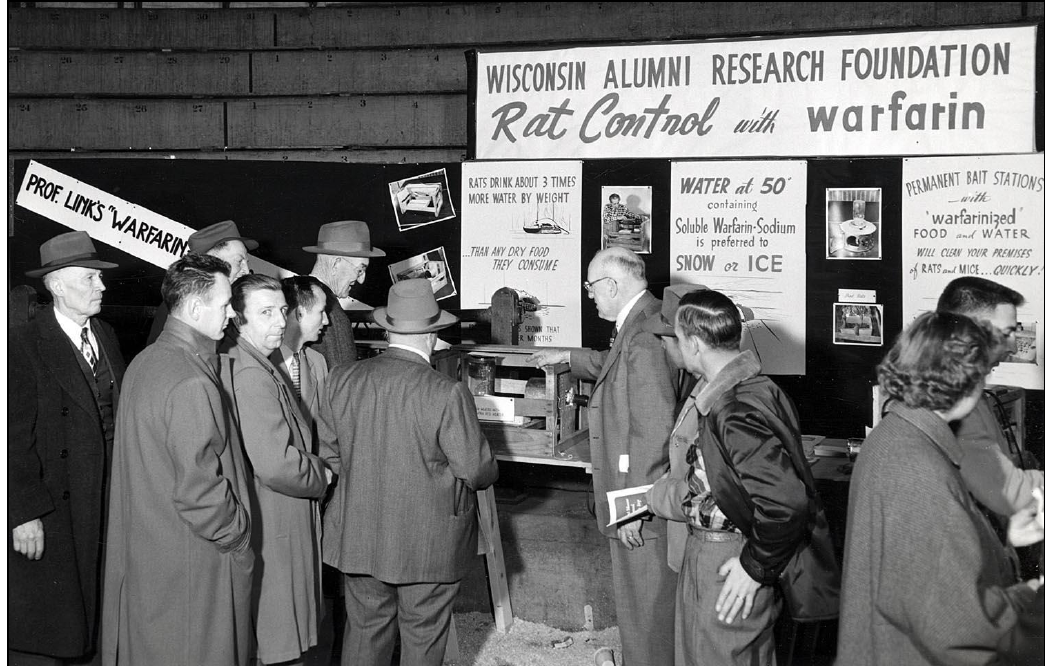
Figure 6. Attendees examine a poster presenting Karl Link’s work on rat extermination with warfarin during the 1954 Farm and Home Week exhibit of the University of Wisconsin College of Agriculture [82].